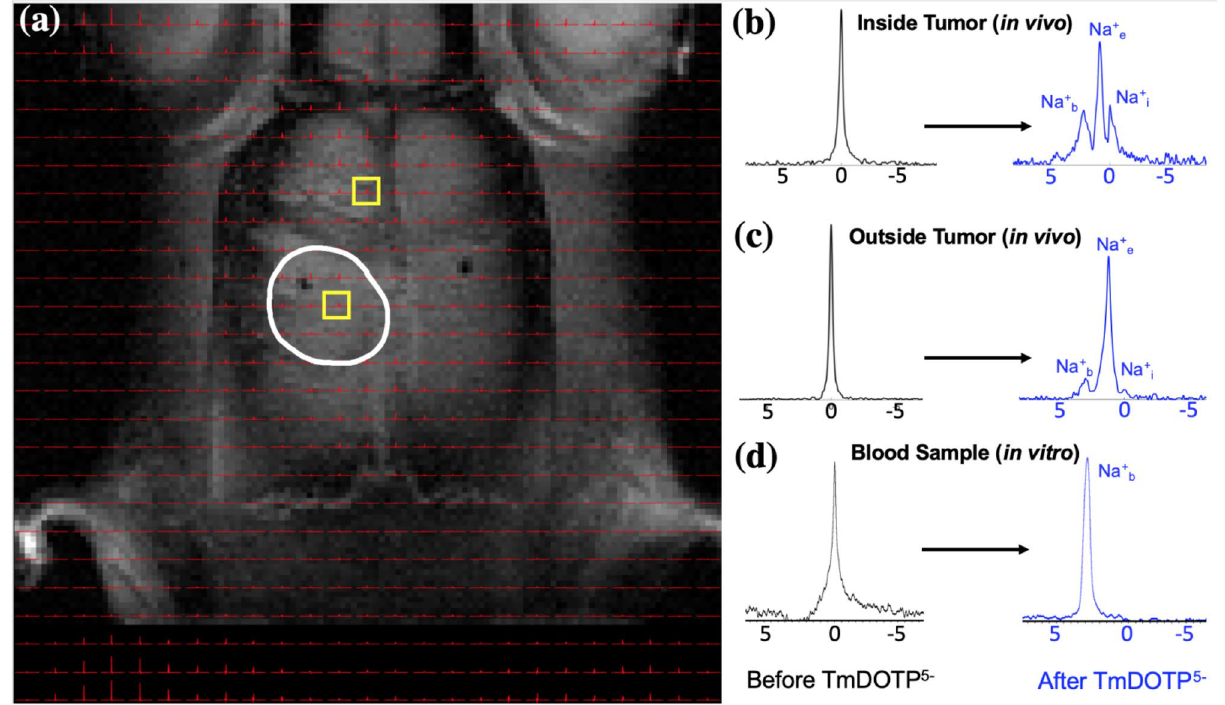
Figure 2. Demonstration of 23 Na peak separation in vivo following TmDOTP 5− administration into a rat bearing a U251 tumor in the brain. ( a ) 1 H-MRI of an axial slice displaying the anatomical tumor boundary (white outline). The 23 Na-MRSI is overlaid on top of the 1 H-MRI. Candidate voxels ( b ) inside and ( c ) outside the tumor are indicated (yellow boxes). Before TmDOTP 5− delivery, a single 23 Na peak was observed at 0 ppm, corresponding to total sodium (Na + T ), both inside and outside the tumor (black spectra). Following TmDOTP 5− delivery, compartmental peak separation was achieved to varying extents throughout the brain (blue spectra). ( b ) Within the tumor, this separation was most pronounced due to a compromised blood–brain barrier (BBB), which permits substantial accumulation of TmDOTP 5− in the extracellular space. ( c ) Outside of the tumor, such a high degree of extravasation would not be possible, but some shifting is still observed. The TmDOTP 5− distribution in the brain warrants labeling the most shifted peak as blood sodium (Na + b ), which occurred consistently around 2 ppm. The unshifted peak, which has no access to TmDOTP 5− , is intracellular sodium (Na + i ). The intermediate peak, therefore, is extracellular sodium (Na + e ), which is shifted more